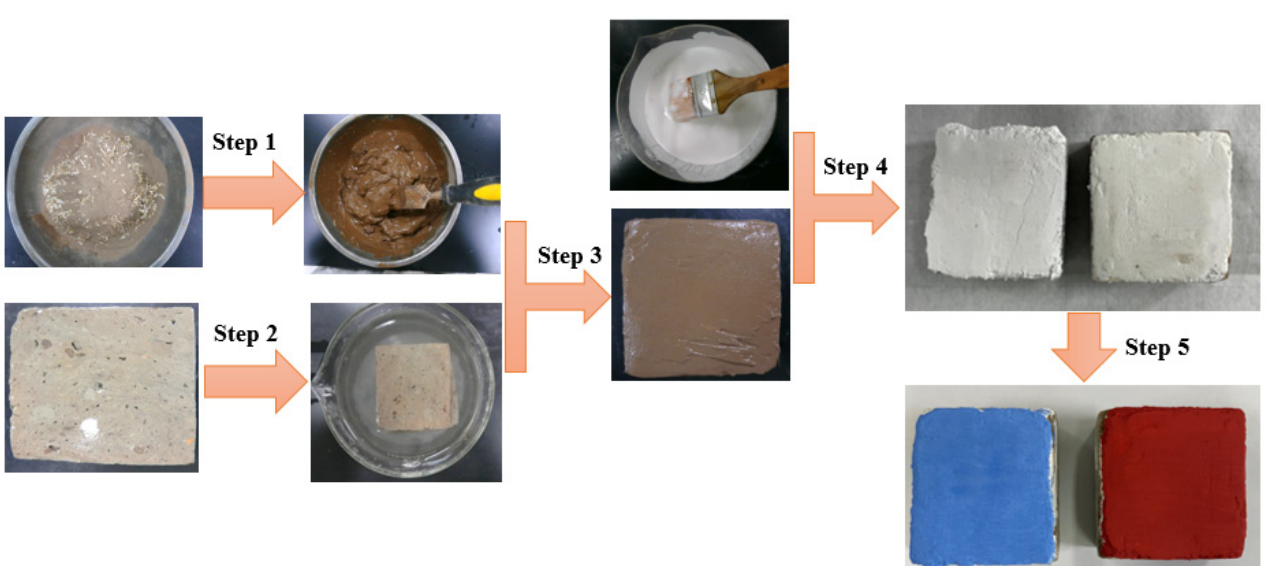
Figure 3. Production process of simulated mural sample block.